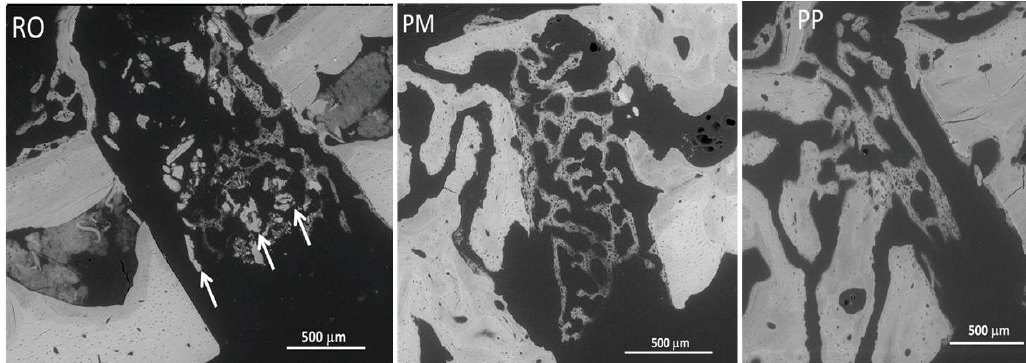
Figure 5. SEM micrographs showing in RO, PM, and PP samples the lower mineralization and higher cell density in the newly formed bony trabeculae inside the osteotomy gaps, compared to the adjacent pre-existing native bone. Some fragments/remnants of osteotomized bone are only present in RO osteotomies (arrows).